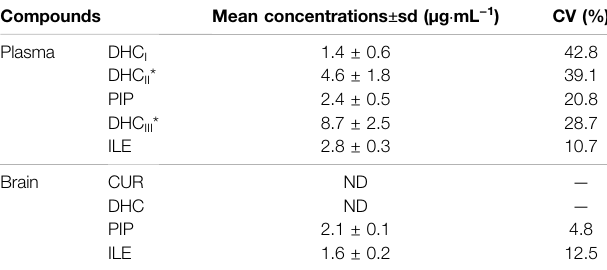
*The results of variance analysis with A showed a signi fi cant difference ( p < 0.05). Group of I: Group of CUR. Group of II: Group of CUR and PIP. Group of III: Group of CUR and ILE.